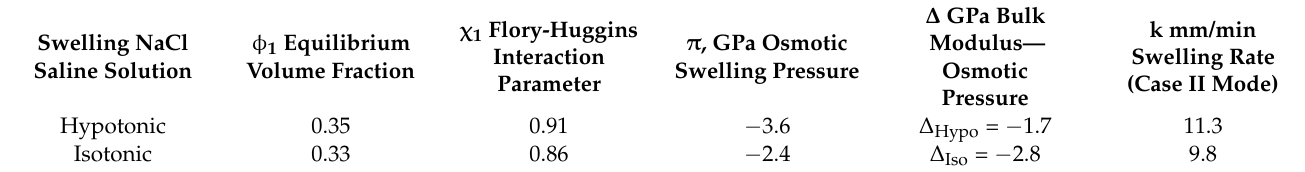
Table 2. Osmotic pressures and sorption properties of Hybrid Hydrogels 1